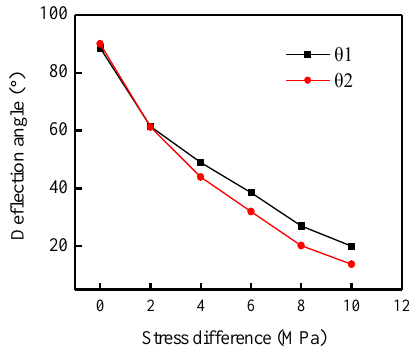
Figure 10. Relationship between stress difference and two deflection angles ( θ 1 and θ 2 corresponding to quarter-length (10 m) and the half-length (20 m) deflection angle, respectively).